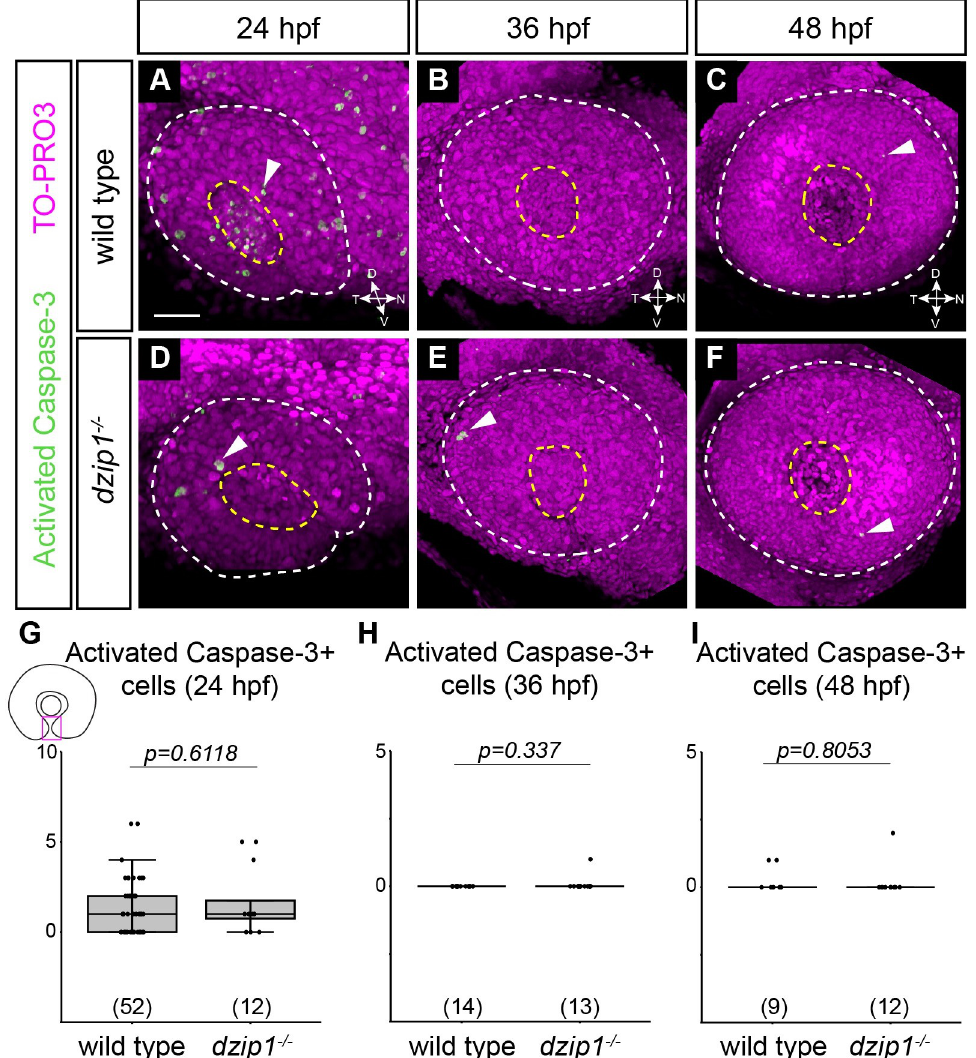
Fig 3. Apoptotic cell death in the optic fissure is not aberrantly upregulated in the dzip1 mutant. (A-F) Whole mount immunofluorescence in wild type (A-C) and dzip1 ts294e mutants (D-F) for cell death ( green ; activated Caspase-3) and nuclei ( magenta ; TO-PRO-3) at 24 hpf (A, D), 36 hpf (B, E), and 48 hpf (C, F). All images are lateral views of 3-dimensional renderings. White dashed lines mark the boundary of the eye; yellow dashed lines mark the lens. Examples of cells labeled with activated caspase-3 elsewhere within the eye are indicated ( white arrowheads ). (G-I) Quantification of total number of activated caspase-3-positive cells within the optic fissure in the eye at 24 hpf, 36 hpf, and 48 hpf. n (embryos) for each genotype shown at the base of the graph. P -values were calculated using Welch’s t-test (M-O). Scale bar: 50 μ m. D, dorsal; V, ventral; N, nasal; T, temporal.